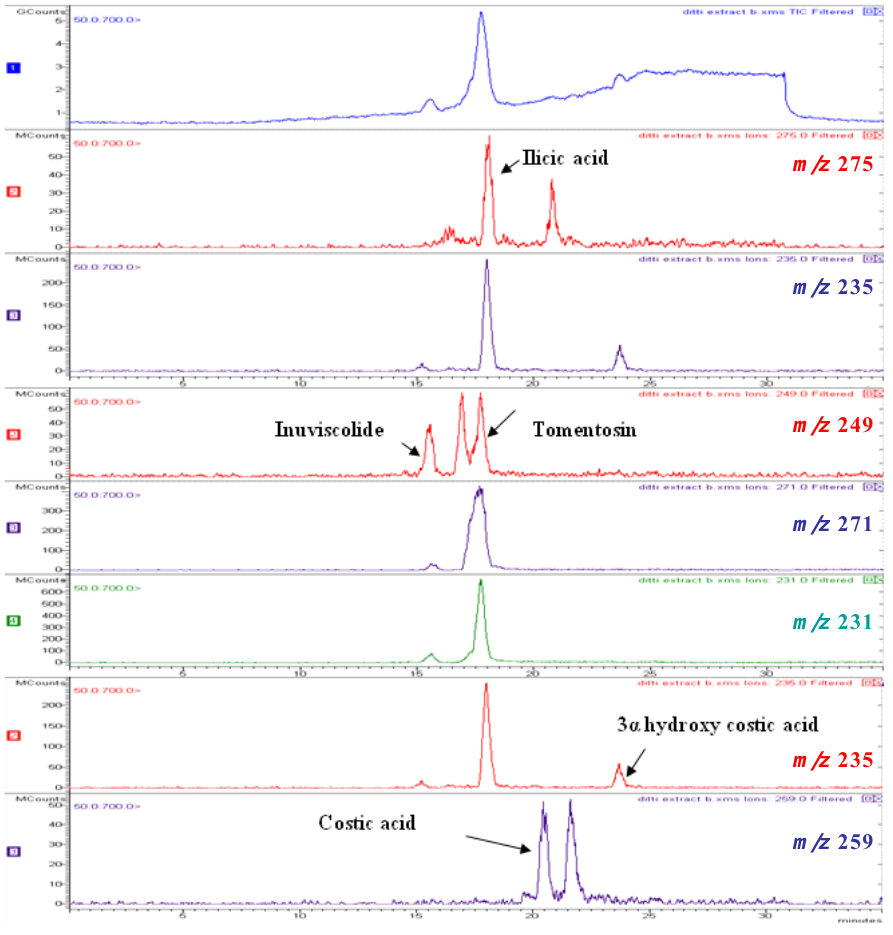
Figure 2. ESI total ion chromatogram of of DvA extract and selected ion monitoring for each compound.